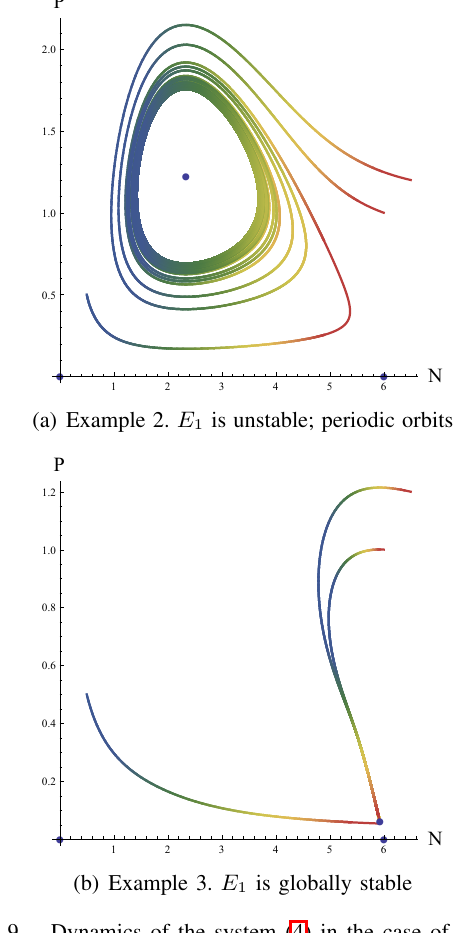
Fig. 9. Dynamics of the system (4) in the case of exactly one internal equilibrium point E 1